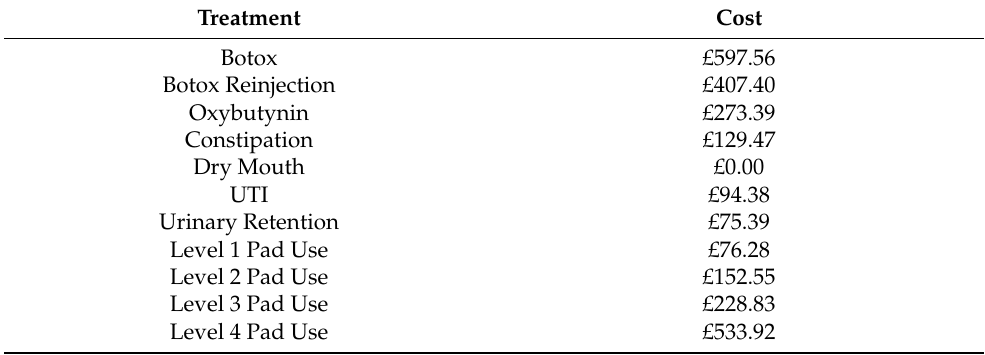
Table 1. Cost of